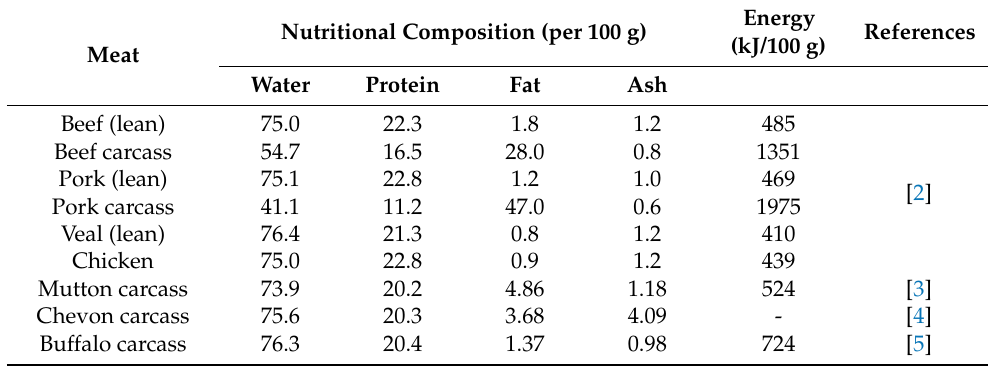
Table 1. Composition of meat from different